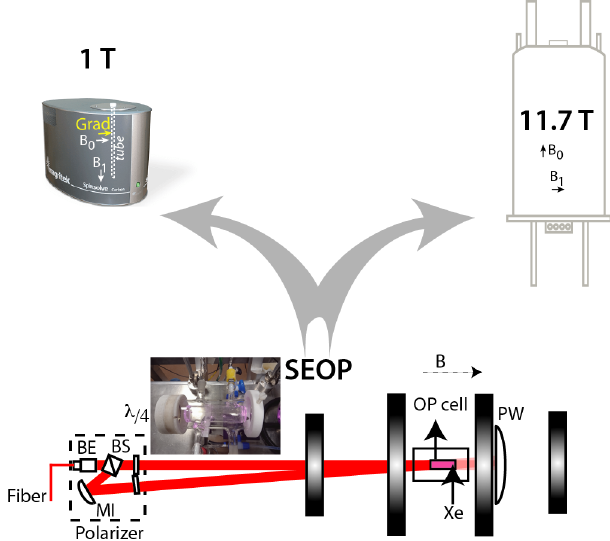
Figure 2. Principle of the experiments. Laser-polarized xenon is produced via spin-exchange optical pumping in batch mode with the setup described in Chauvin et al. (2016). BE: beam expander; BS: polarization beam-splitter cube; MI: mirror; λ/ 4: quarter-wave plates; PW: power meter. The black vertical rectangle represents the coils, which deliver a magnetic field B co-linearly to the photon beam. A picture of the optical pumping cell is given in the inset. Af- ter some minutes of optical pumping, frozen hyperpolarized xenon is transported to the NMR spectrometers. The disposition of the NMR tube inside the magnet, the static and radiofrequency fields as well as the axis of the gradient are indicated on the benchtop